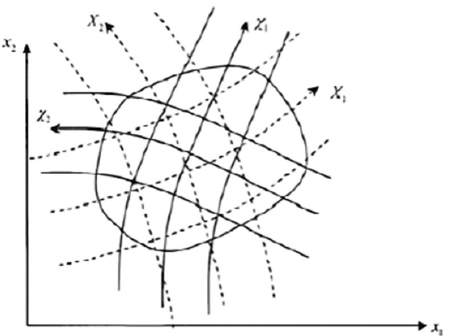
Figure 1. The plot of Lagrange, Euler, and ALE coordinates.